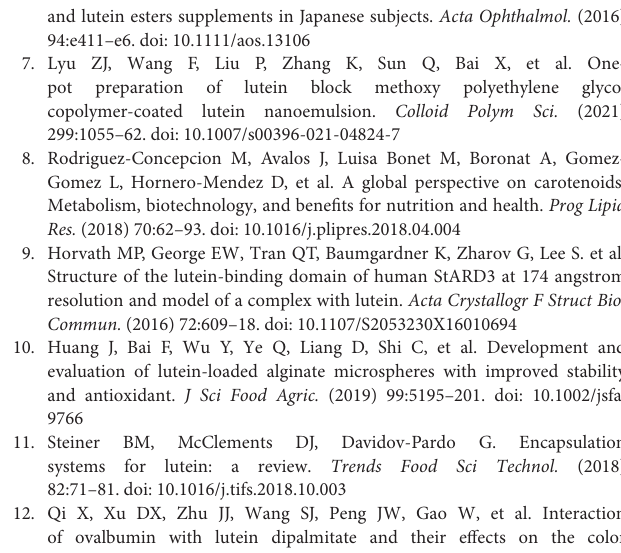
XRD. The results indicated that lutein was spontaneously bound to GSPI at a stoichiometric of 1:1. The fluorescence of GSPI was quenched by static quenching during the binding process, which slightly affected the secondary structure of GSPI. Finally, the total color difference and degradation rate results showed that GSPI had a better stabilization effect on